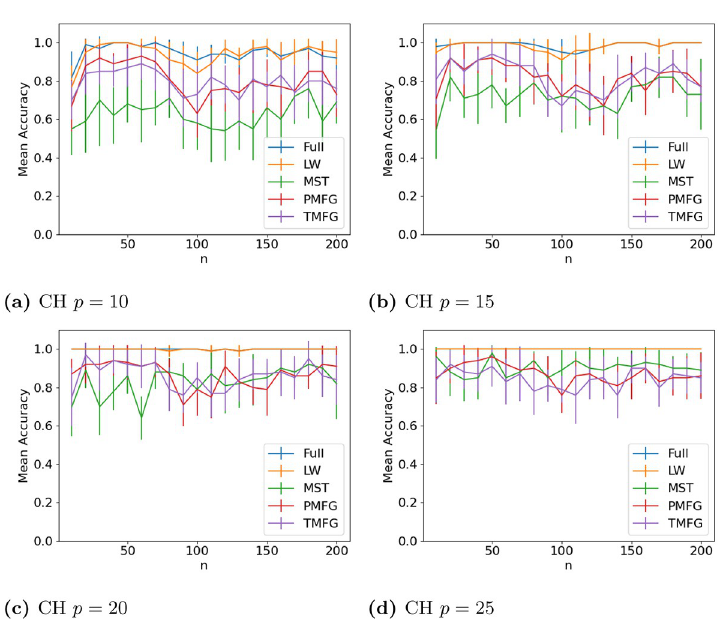
Fig 19. Accuracy when distinguishing between correlation matrices inferred from adjacent time windows based on the median volatility using the SF method and a random forest classifier for Chinese stock returns. (a) CH p = 10, (b) CH p = 15, (c) CH p = 20, (d) CH p = 25.